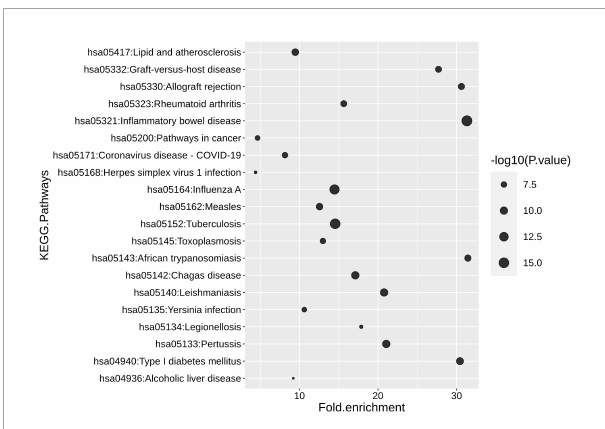
FIGURE 6 The top 20 human diseases and signaling pathways associated with the DC model. P -values and fold enrichment of KEGG pathways in DC. -log 10 of P-values was used for visualization. Thus, larger dot sizes correspond to lower P -values. The cutoffs P -value < 0.05 and a false discovery rate (FDR) < 5% were set for signi fi cant